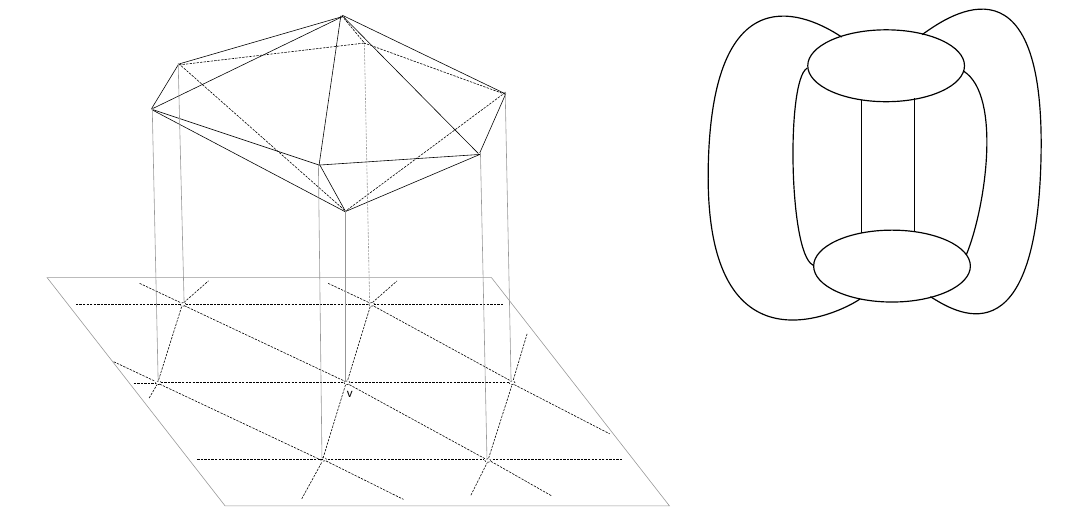
Figure 38 . Left: the projector P v can be computed as a state-sum model evaluation of a bi- pyramid. The bi-pyramid partition function is interpreted as a map from the dual of the vector space associated to the bottom faces to the vector space associated to the top faces. The action of the projector on the microscopic Hilbert space of the string-net model corresponds to gluing the bi-pyramid on top of the vertex v . Right: the bi-pyramid is computed in the spherical fusion category by an appropriate planar graph dual to the bipyramid surface. The oval faces are dual to the top and bottom vertices of the